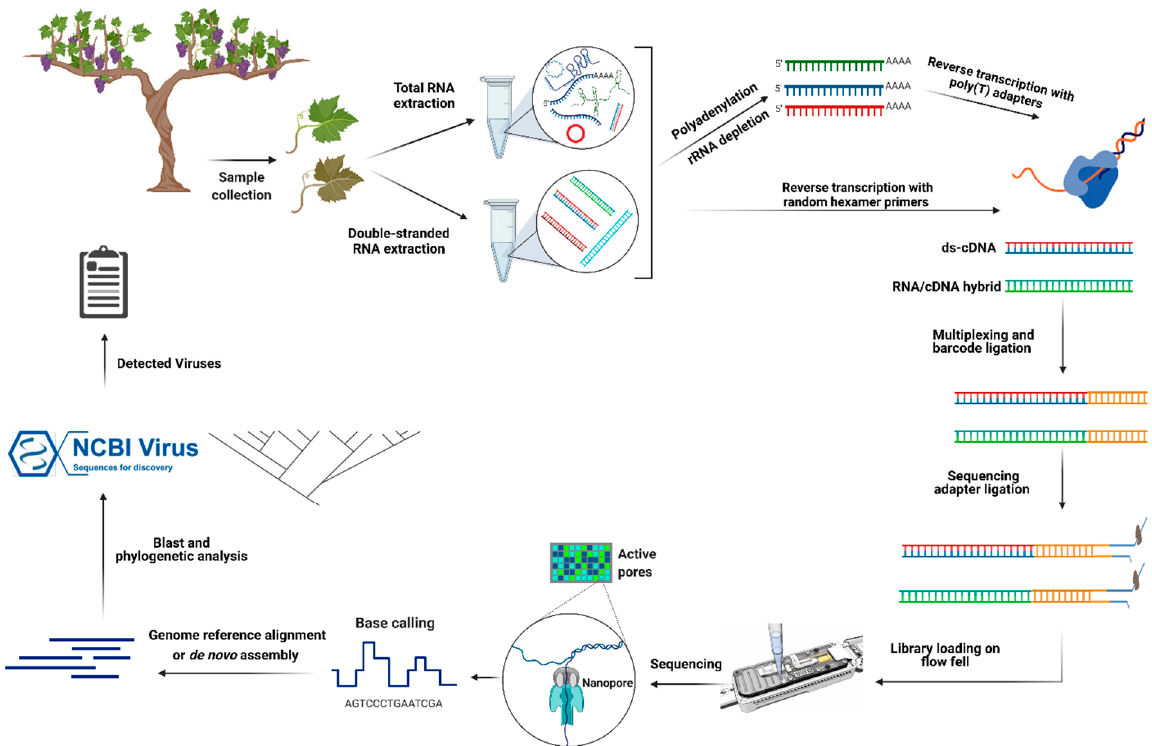
Figure 2. Illustration of the principles of nanopore direct cDNA and RNA sequencing for grapevine RNA virus detection. In direct RNA sequencing, after total RNA extraction, rRNAs are depleted using specific probes. To capture non-poly(A) viral RNAs, polyadenylation is performed. The first strand of cDNA is transcribed by using poly(T) adapters. In addition, different barcodes can be used to multiplex several libraries and sequence them using one flow cell. Then, the sequencing adapter is ligated, and the library (or pooled libraries) is loaded onto a flow cell. Finally, the sequencing step is run by setting up different options in MinKNOW software. After basecalling, downstream analysis steps are performed, and the list of detected viruses is extracted. In direct cDNA sequencing, after dsRNA extraction, double-stranded cDNAs are synthesized with random hexamer primers, and the subsequent steps are similar to direct RNA sequencing. Created with BioRender.com (accessed September 15th 2021)